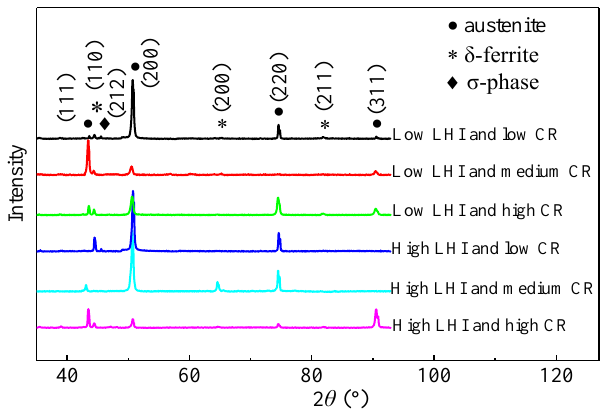
Figure 4. XRD patterns of the AM parts under different LEIs and cooling rates (CRs).